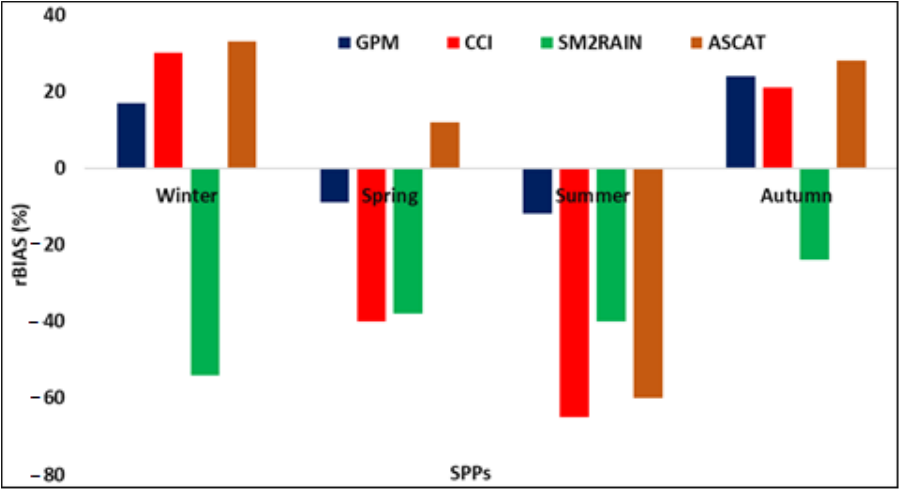
Figure 11. rBIAS (%) all SPPs on seasonal scale.